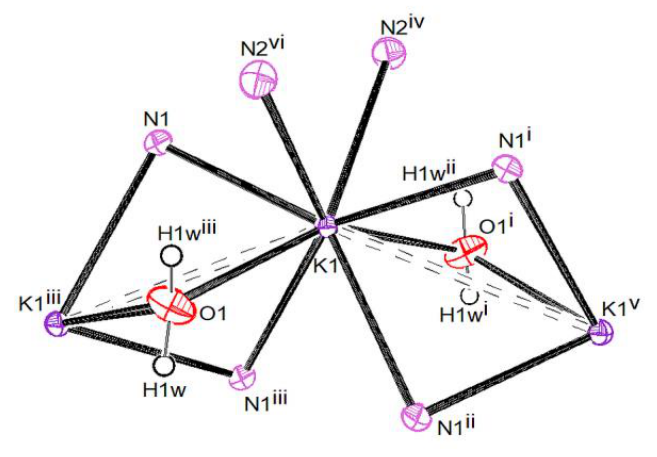
Figure 13. The coordination sphere of K + in compound 6a . Symmetry operators: i: – 1 – x , y , ½ – z ; ii: x –